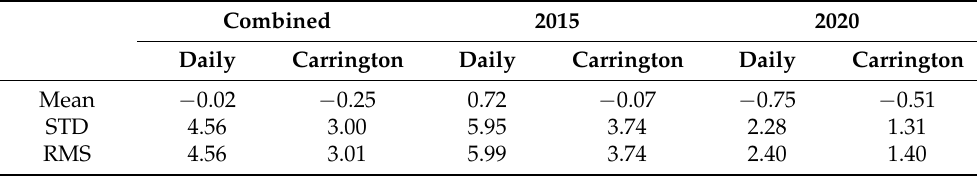
Table 1. Quality measures of the daily test data and the Carrington averaged test set.